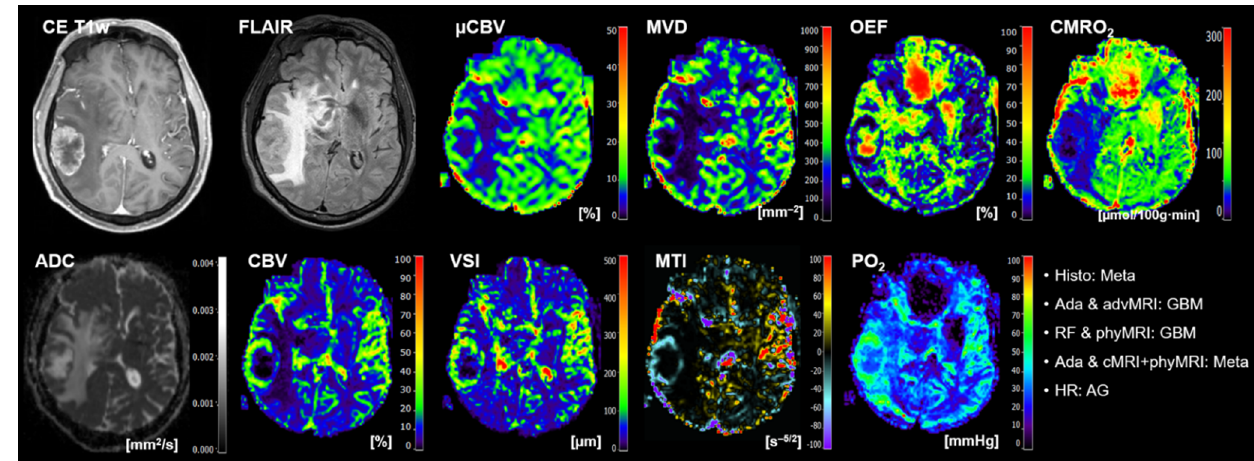
Figure 5. Representative case of a patient (number 15 in Table 5) suffering from an anaplastic glioma (AG, WHO grade 3) who was misclassified as primary CNC lymphoma (PCNSL) by the radiologists but correctly classified by all three best ‐ performing ML classifiers. Contrast ‐ enhanced (CE) T1w and FLAIR MRI data were conventional MRI (cMRI) data; cMRI data combined with the quantitative maps of apparent diffusion coefficient (ADC) and cerebral blood volume (CBV) were advanced MRI (advMRI) data; physiological MRI (phyMRI) data included the quantitative maps of microvascular cerebral blood volume ( μ CBV), microvessel density (MVD) microvessel radius (VSI), microvessel type indicator (MTI), oxygen extraction fraction (OEF), cerebral metabolic rate of oxygen (CMRO 2 ), and tissue oxygen tension (PO 2 ), respectively.